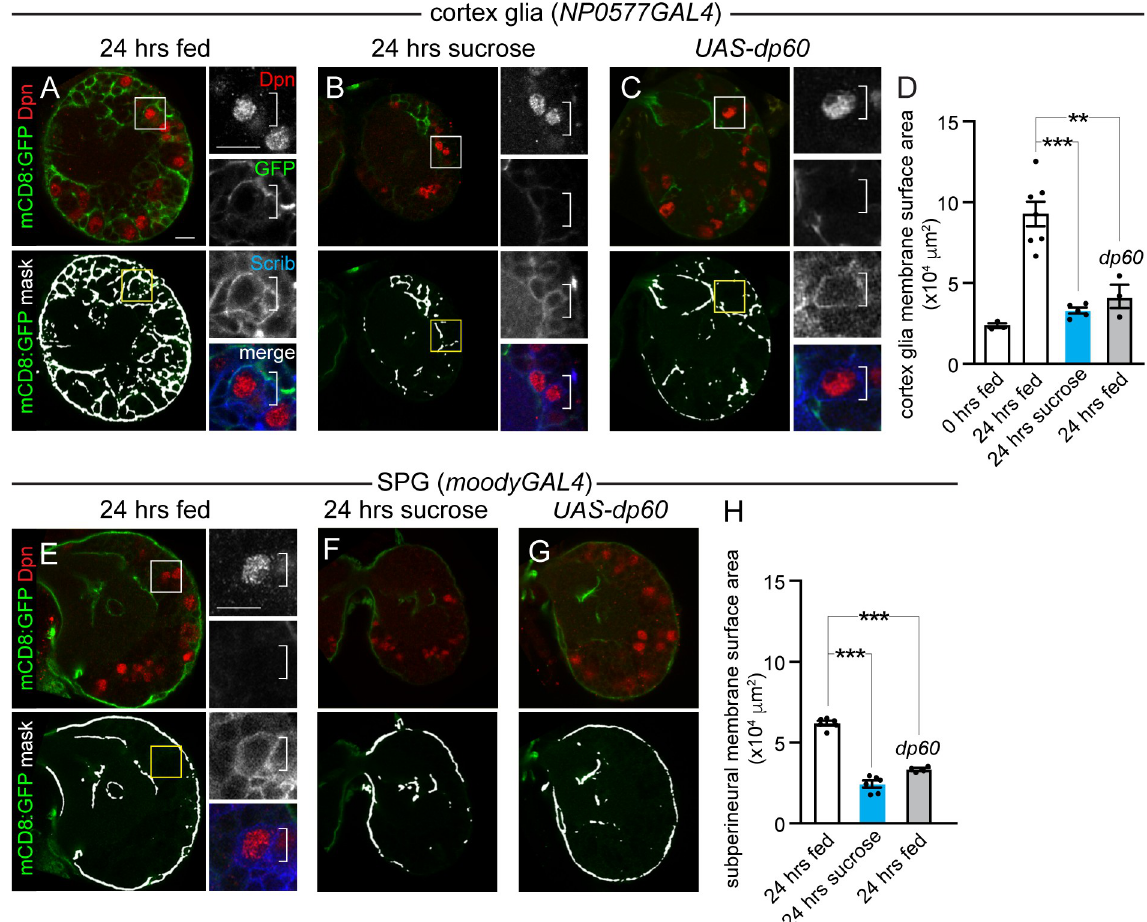
Fig 3. Growth of cortex glia and SPG is nutrient regulated and PI3-kinase dependent. (A-C) Cortex glial membrane morphology after 24 hours of feeding standard food (A and C) or sucrose (B). (A–C) Single Z planes of brain hemispheres. Top panels are colored overlays, and bottom panels are single-channel images with the mask overlays used for quantification of cortex glia membrane surface area (D). Boxed Dpn- positive NBs are shown at higher magnification to the right. (E–G) SPG and neuropil glial membrane morphology after 24 hours of feeding on standard food (E and G) or sucrose (F). (J–L) Single Z images of brain hemispheres. Top panels are colored overlays, and bottom panels show single-channel images with the mask overlay used for quantification of SPG and neuropil membrane surface area (H). Dpn-positive NBs denoted in the box shown at higher magnification to the right. One-way ANOVA with Tukey post hoc analysis, �� p < 0.01, ��� p < 0.001. Error bars, SEM. Genotypes of panels listed in S2 Table and data listed in S1 Data. Dpn, Deadpan; dp60 , Drosophila protein 60 ; GFP, green fluorescent protein; mCD8, membrane-targeted CD8 antigen; NB, neuroblast; PI3-kinase, phosphoinositide 3-kinase; Scrib, Scribble; SPG, subperineurial glia; UAS , upstream activating